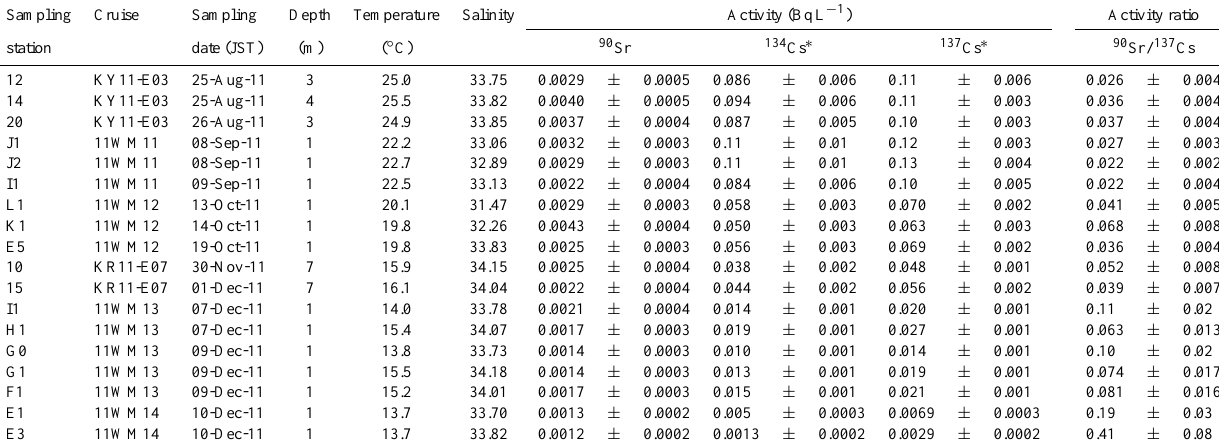
Table 4. Hydrographic parameters, activities of 90 Sr, 134 Cs, and 137 Cs. and 90 Sr/ 137 Cs activity ratios in the water samples. Sampling Cruise